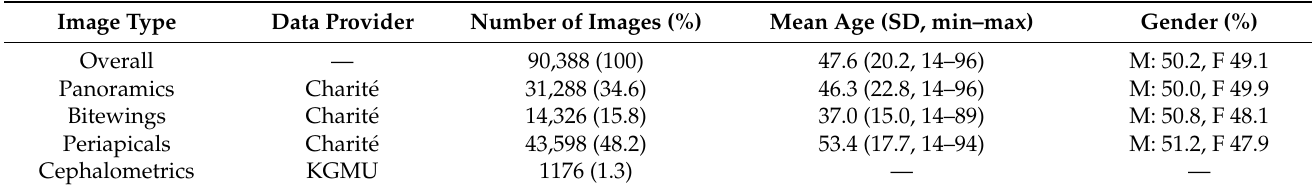
Table 1. Characteristics of the image